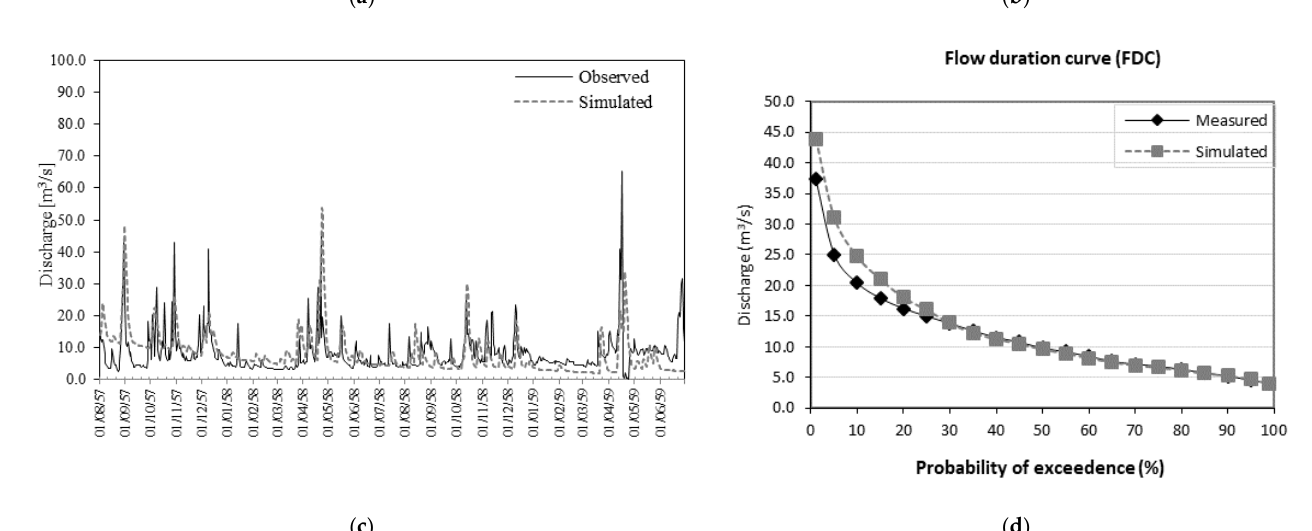
Figure 4. Mubuku calibration plot ( a ), accumulated discharge plot ( b ), Validation plot ( c ) and Flow Duration Curve ( d ).